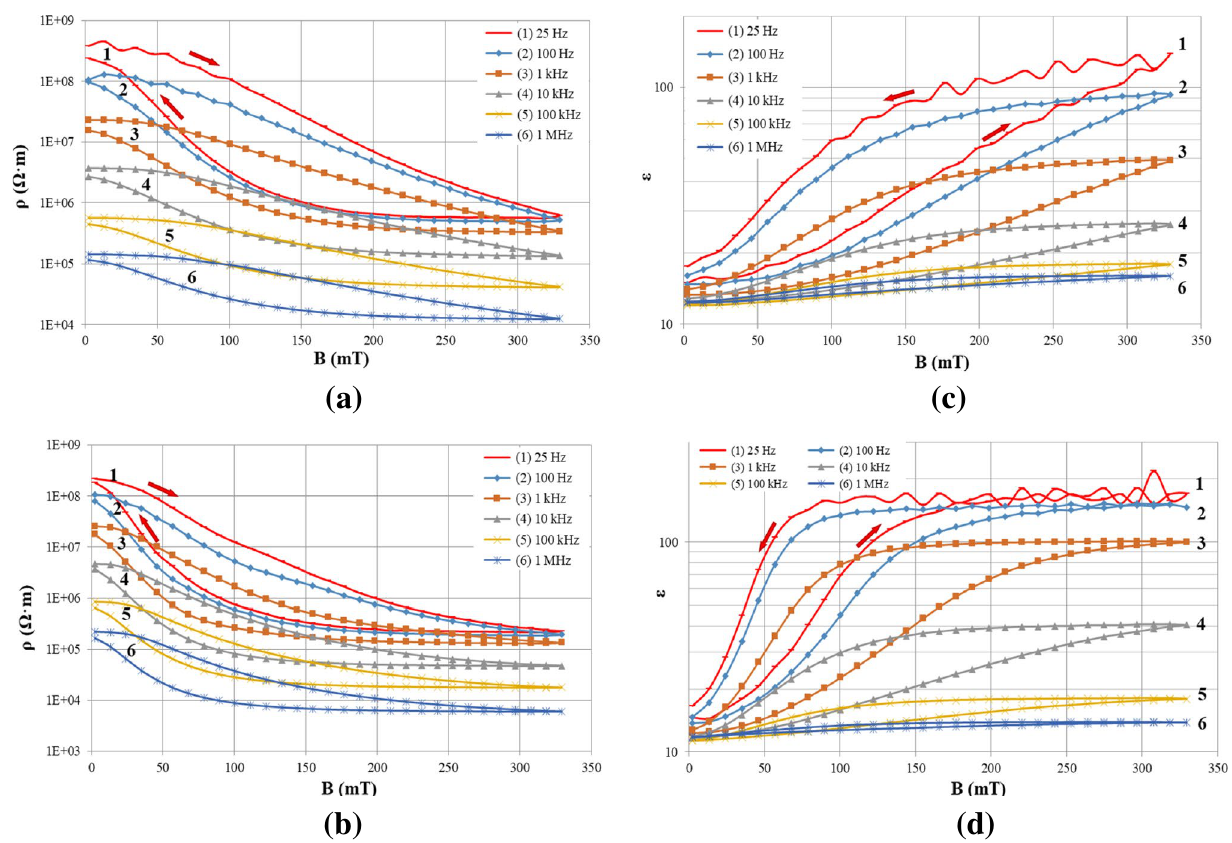
is applied in a parallel ( a , c ) (variant A, ref. to Fig. 5) and perpendicu- lar ( b , d ) (variant B, ref. to Fig. 5) way to the normal of the sample surface. The way the specified parameters change with the field is shown with